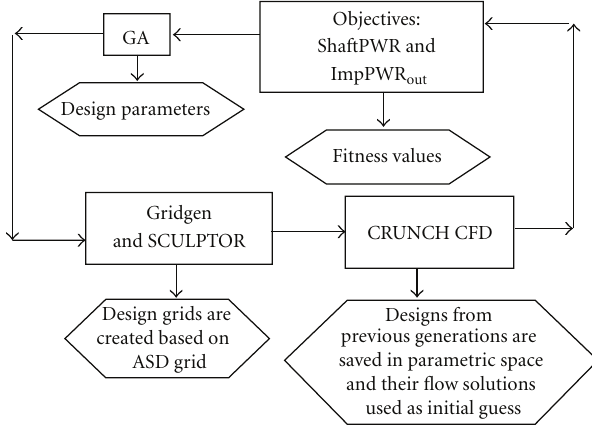
Figure 10: Flowchart for blade